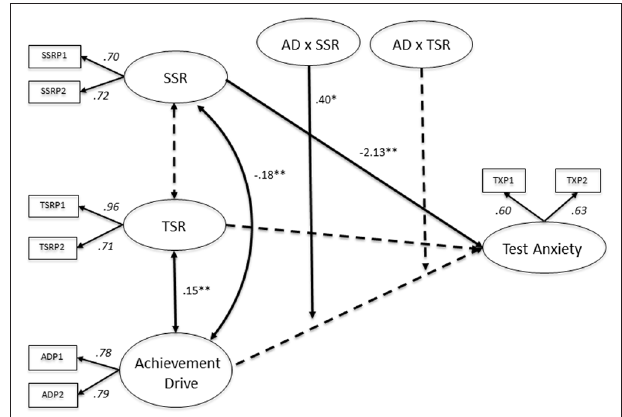
FIGURE 3 | Multigroup latent moderated structural equations (MGLMS) for the German sample. Significant effects shown as unstandardized coefficients (B), bold pathways are significant at * p < 0.05, ** p < 0.001; dotted pathways are not significant. Factor loadings are standardized (based on the standardized results of the weak measurement model seen as the final model only reports unstandardized results). TSR, teacher–student relationships; SSR, student–student relationships; AD, achievement drive.